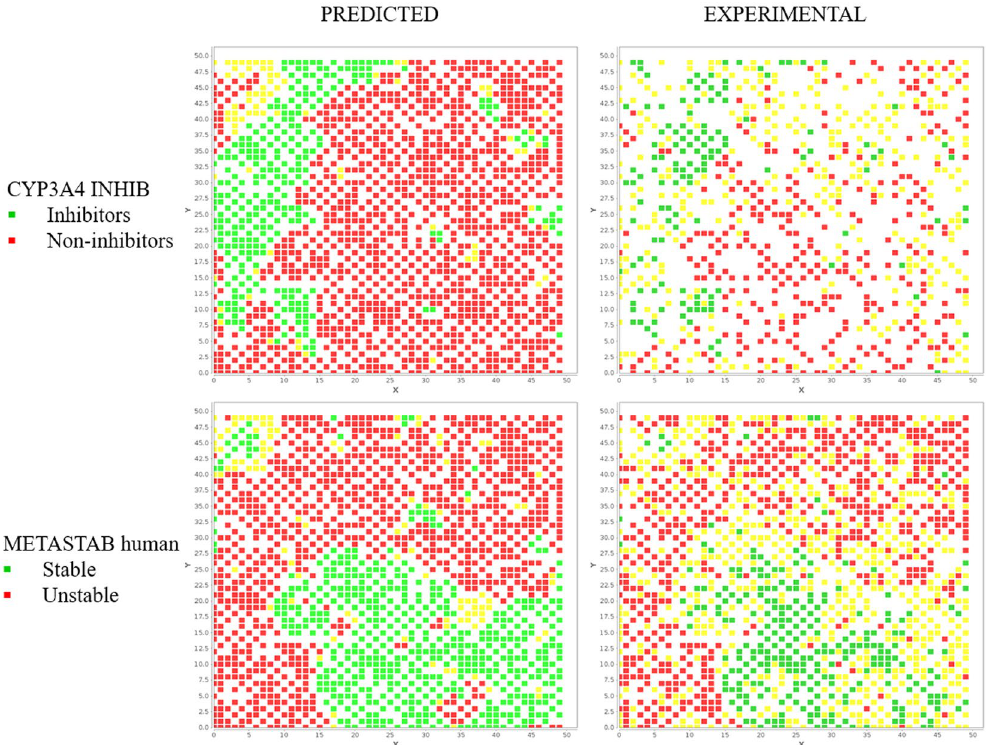
Figure 3. Comparison between predicted and experimental distributions for CYP3A4 INHIB and METASTAB human. Uncertain nodes are coloured in